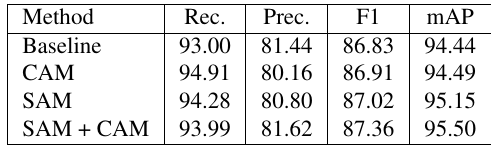
Table 1. Metrics results, in [%], for the four methods evaluated. Since there are a few crosses between the curves of CAM and baseline methods and between SAM and dual-attention meth- ods, we must analyse metrics results numerically to further con- clusions. Table 1 shows that methods using spatial attention mechanisms indeed outperformed CAM and baseline